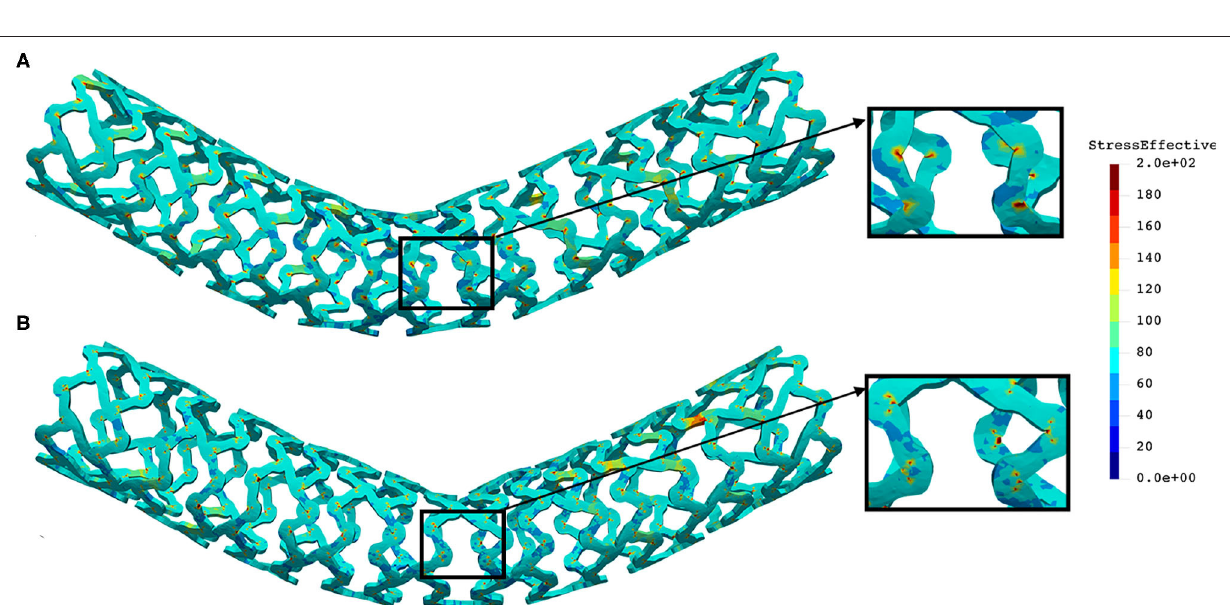
FIGURE 11 | Effective stress distribution on PLLA prot (A) and PLLA prot-slots (B) stents for three-point bending test.